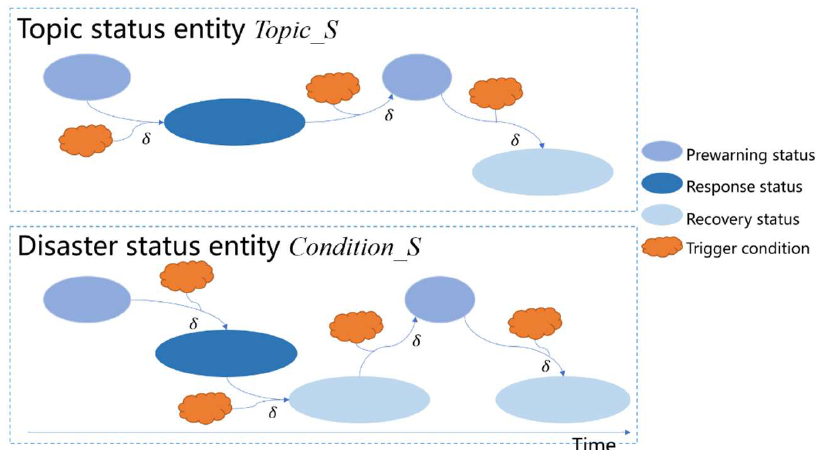
Figure 7. Schematic diagram of presentation results of the status-level dynamic expression class.